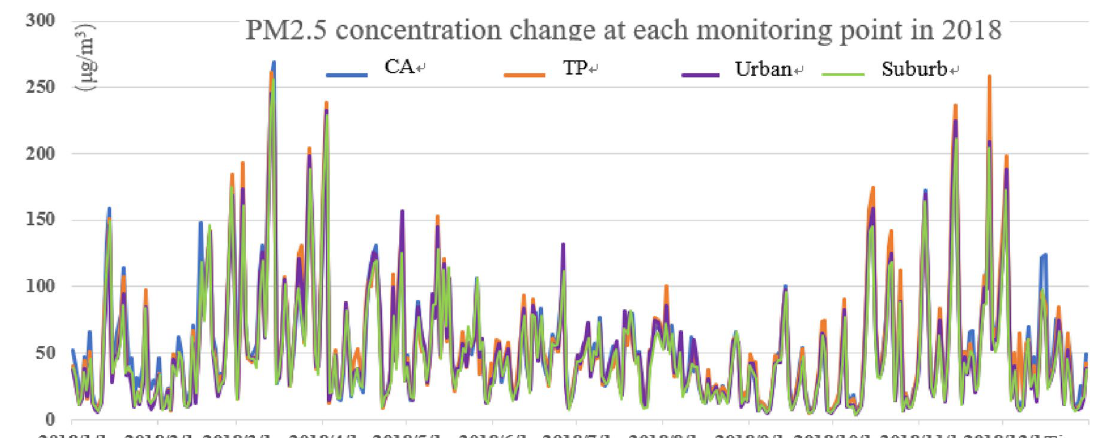
Figure 2. Schematic diagram of the LSTM structure.